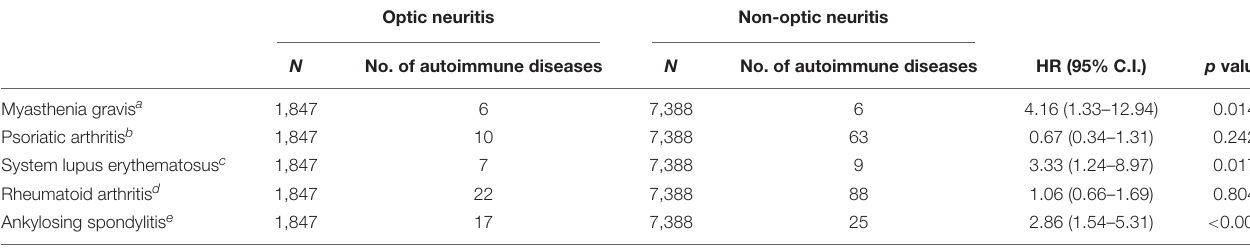
TABLE 5 | Sub-outcome analysis of the association between optic neuritis and autoimmune diseases. Optic neuritis Non-optic neuritis N No. of autoimmune diseases